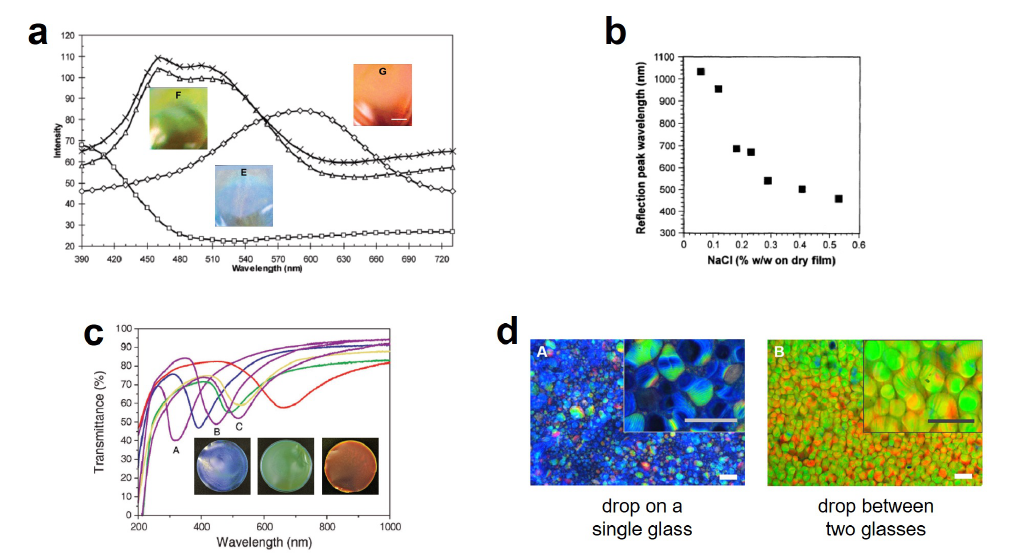
Figure 13. Examples of parameters and conditions affecting the selective reflection of films formed by drying CNC suspensions. ( a ) Impact of ultrasonication treatment. Photographs (insets) and reflection spectra (diagram) of CNC films prepared from suspensions treated with ultrasonication energies of 750 J/g CNC (E) and 2225 J/g CNC (G). Film (F) was prepared by drying a 1:1 mixture of the suspensions used to prepare films (E) and (G). The scale bar is 1 cm. Adapted with permission from Ref. [198]. Copyright 2011 American Chemical Society. ( b ) The influence of electrolyte addition. Increasing the concentration of NaCl added to an acid-form CNC suspension leads to a decrease in the wavelength of the reflection band of the dried CNC films. Reprinted with permission from Ref. [3]. Copyright 1998 Pulp and Paper Technical Association of Canada. ( c ) The effect of added polymers. Transmission spectra and reflection photographs of films of CNC/polyethylene glycol composite films (diameter 9 cm) at various CNC/polymer compositions; blue: 90/10; green: 80/20 and red: 70/30. Adapted with permission from Ref. [134]. ( d ) The effect of surface anchoring and orientation of liquid crystalline CNC suspensions. Cross-polarized images of films dried in water vapor saturated atmosphere assisted by orbital shear with a glass coverslip off (left) and on (right) during drying. The scale bars are 100 µ m. Reprinted with permission from Ref. [201]. Copyright 2018 American Chemical